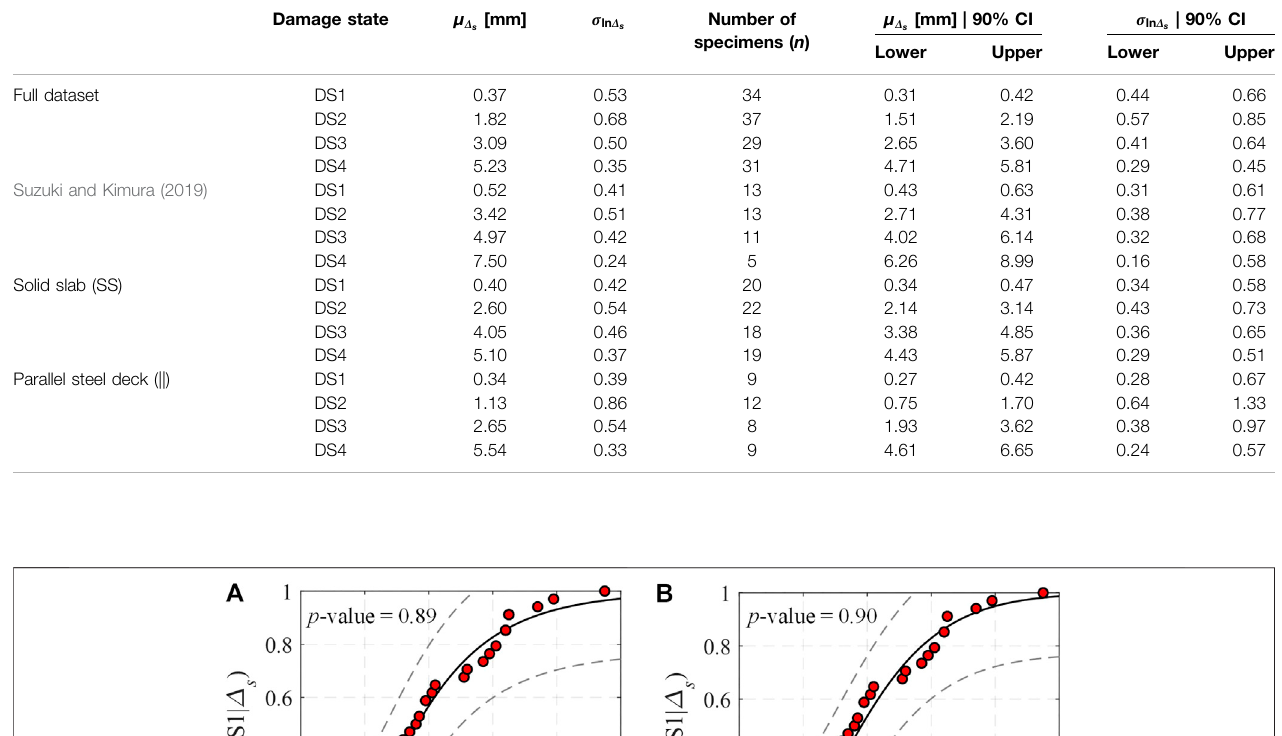
Frontiers in Built Environment |